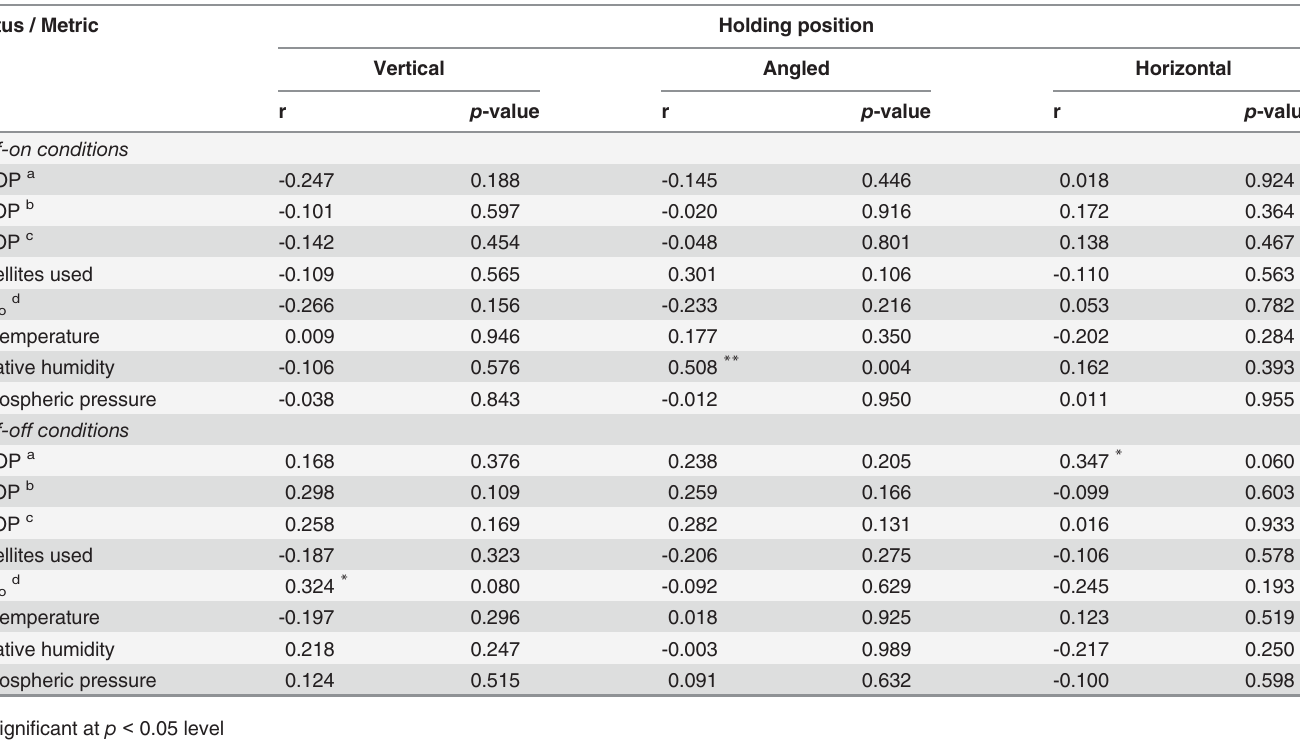
Table 5. Correlation between static horizontal position accuracy (as expressed by the root mean squared error of 30 samples) and other metrics of interest when using the Flint GNSS receiver in the coniferous